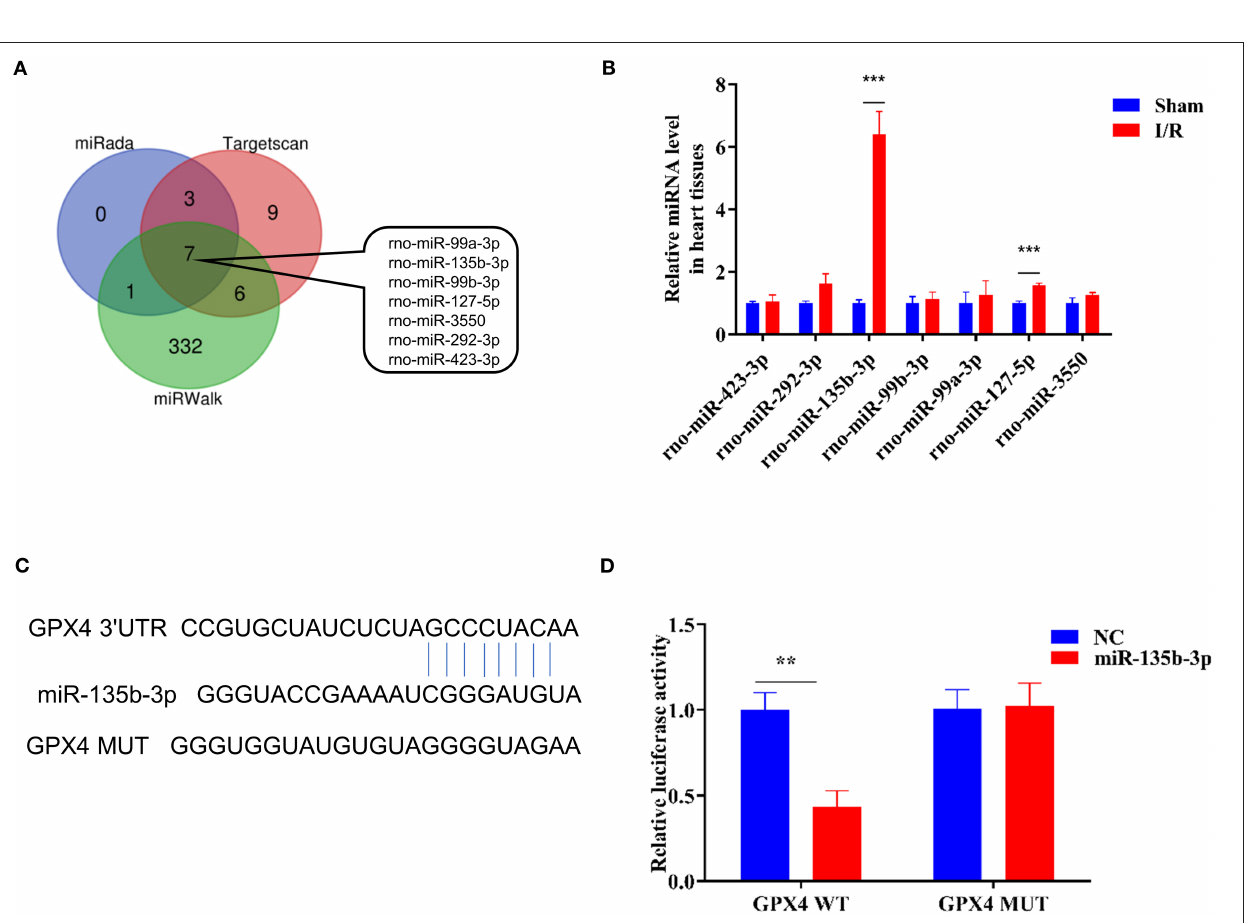
FIGURE 2 | Gpx4 is a direct target of miR-135b-3p. (A) Prediction of miRNAs that target Gpx4 using TargetScan, miRWalk, and miRada database. (B) Detection of miRNA expression in sham and I/R myocardial tissues of rats using RT-qPCR ( n = 3). (C) The putative miR-135b-3p-binding sites in 3’UTR of wild-type and mutant Gpx4 . (D) Relative luciferase activity of the cells co-transfected with constructed luciferase reporters ( Gpx4 -3 ′ UTR-WT and Gpx4 -3 ′ UTR-MUT), pRL-TK vectors, and miR-135b-3p mimics or negative control ( n = 3). *** p < 0.001, ** p < 0.01. Error bars represent the mean ± SD of triplicate